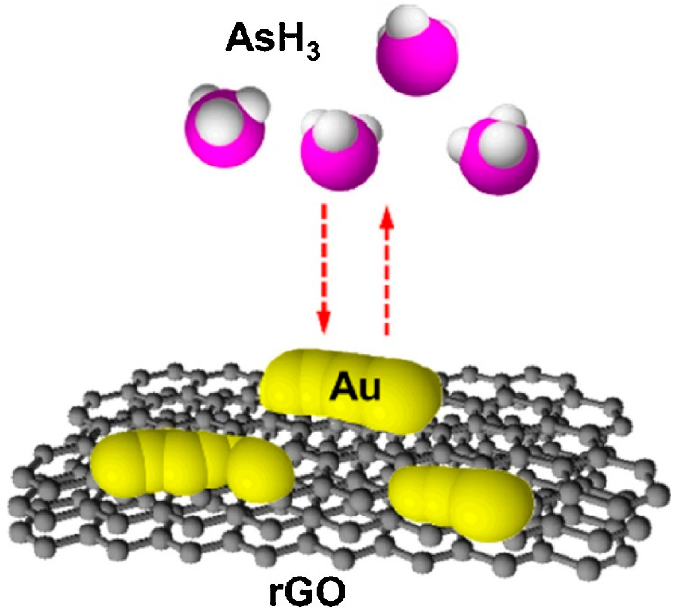
Figure 6. The graphic of the AsH 3 gas sensor based on Au-modified rGO. Reproduced with permis- sion from [163]. Copyright © 2021 Elsevier B.V. All rights reserved.